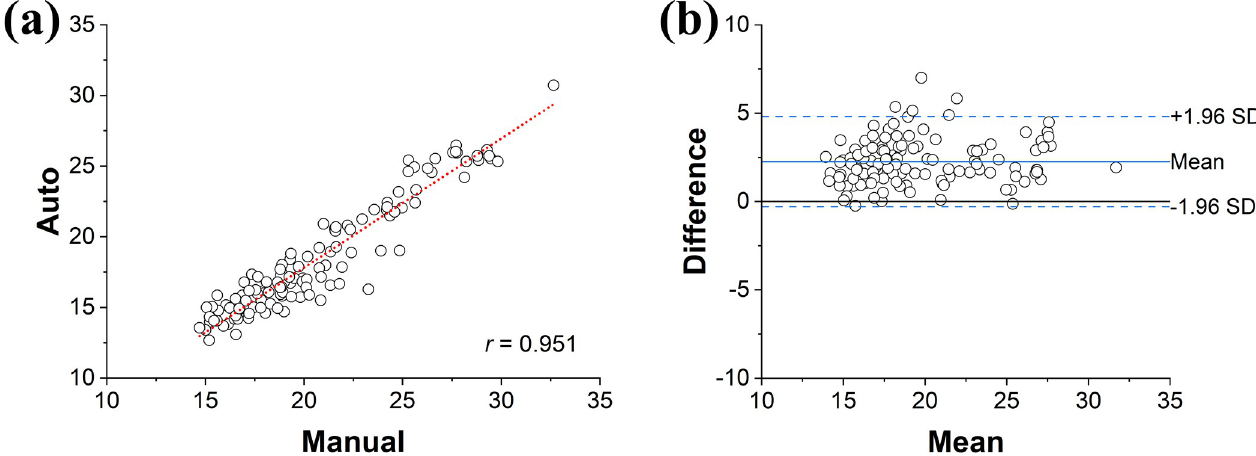
Fig 4. Agreements between automated and manual noise level measurement. (a) A scatter plot with linear regression showing a Pearson’s correlation coefficient of 0.951, and (b) a Bland-Altman plot where the solid and dashed red lines indicate the mean difference and 95% limits of agreement.